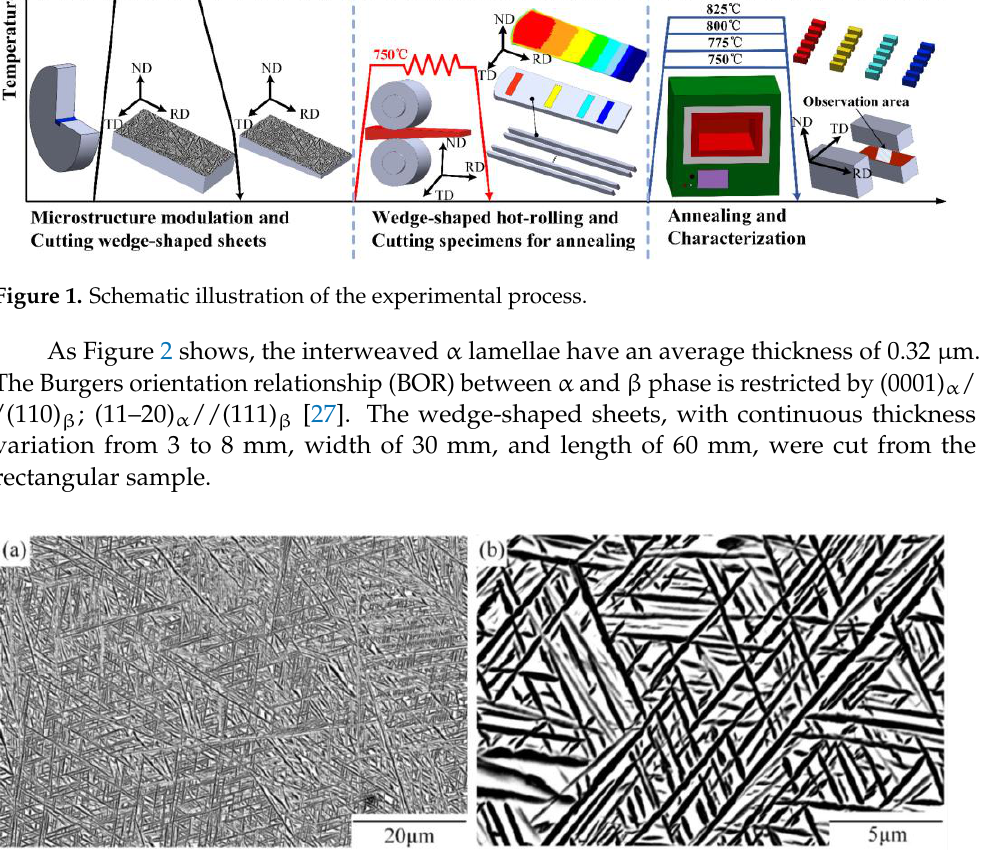
Figure 2. Microstructure of Ti-55511 alloy before hot rolling: ( a ) low and ( b ) high magnification.